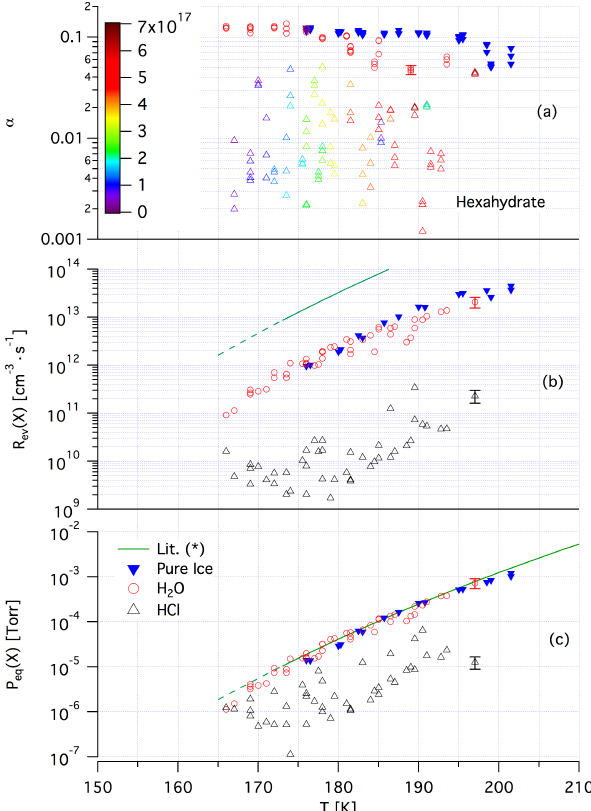
Figure 5: Synopsis of kinetic results for HH using H 2 O, HCl as a probe gas. The 1218 Figure 5. Synopsis of kinetic results for HH using H 2 O, HCl as a probe gas. The symbols used are explained in the text. The cal- symbols used are explained in the text. The calculated relative error for α is 10%. The 1219 culated relative error for α is 10%. The relative errors calculated relative errors calculated for R ev (HCl) and P eq (HCl) are 30% whereas for R ev (H 2 O) 1220 for R ev (HCl) and P eq (HCl) are 30%, whereas for R ev (H 2 O) and and P eq (H 2 O) they are 25%. Examples of the amplitude of the errors are reported for 1221 P eq (H 2 O) they are 25%. Examples of the amplitude of the errors selected points. The green line shows results from Marti and Mauersberger, 1993. The 1222 are reported for selected points. The green line shows results from colour scale shows the cumulative adsorbed dose after HCl pulsed gas admission. 1223 Marti and Mauersberger (1993). The colour scale shows the cumu- lative adsorbed dose after HCl pulsed gas